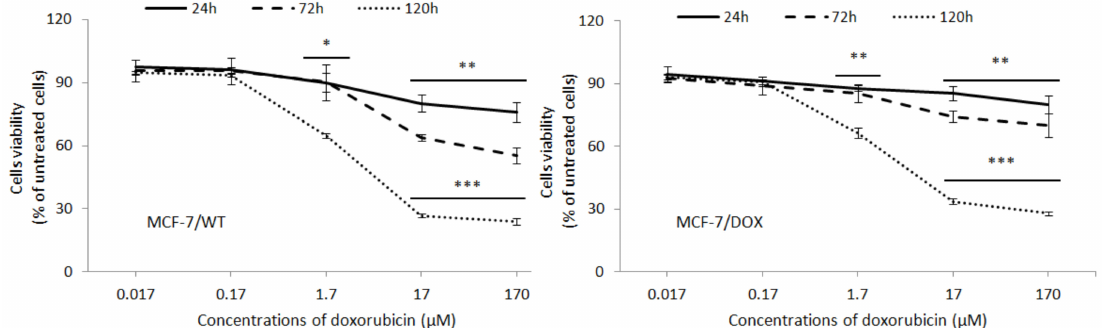
Figure 1. The results of the 3(4,5-dimethylthiazol-2-yl)-2,5-diphenyltetrazolium bromide (MTT) assay following cytotoxicity tests with doxorubicin (DOX) at a range of 0.017–170 µ M concentration on human breast adenocarcinoma cell lines sensitive (MCF-7 / WT) and resistant to doxorubicin (MCF-7 / DOX). After being incubated for 10 min with DOX, cells were incubated in complete culture medium 24, 72 and 120 h. Statistically significant di ff erences between DOX-treated cells and nontreated control (* p ≤ 0.05; ** p ≤ 0.005; *** p ≤